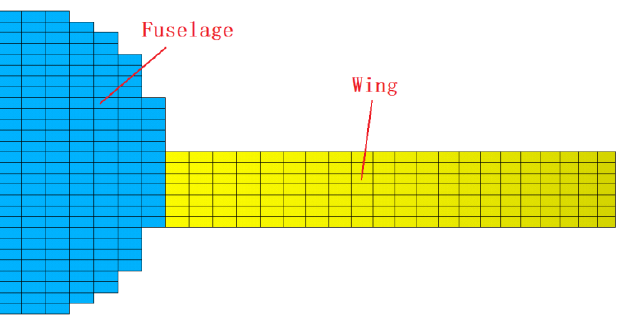
Figure 4. Finite element model of half SC containment. ( a ) Steel plate; ( b ) Rebar of cylinder; ( c ) Rebar of dome.